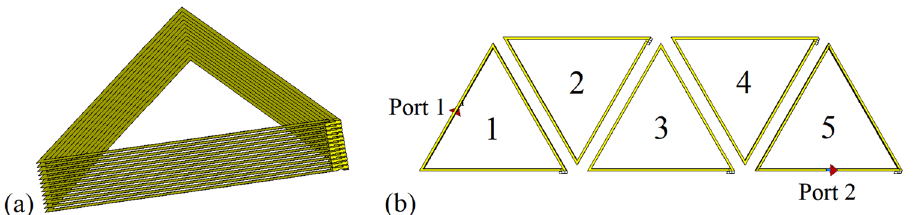
Figure 6. ( a ) A thirteen-layer helical triangular coil. ( b ) Simulation model of five units arranged in line, with a transmitting coil, a receiving coil and two ports.